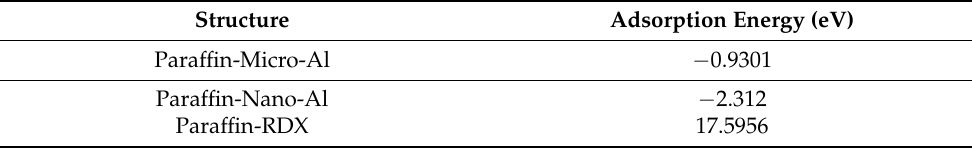
Table 8. Corresponding adsorption energy between